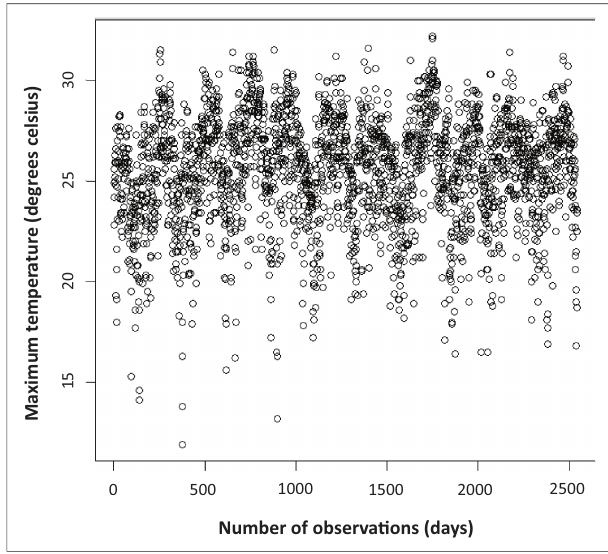
FIGURE 1: Plot of average maximum daily temperature (°C) for the period 2000−2010. Only data for the period September–April of each year are